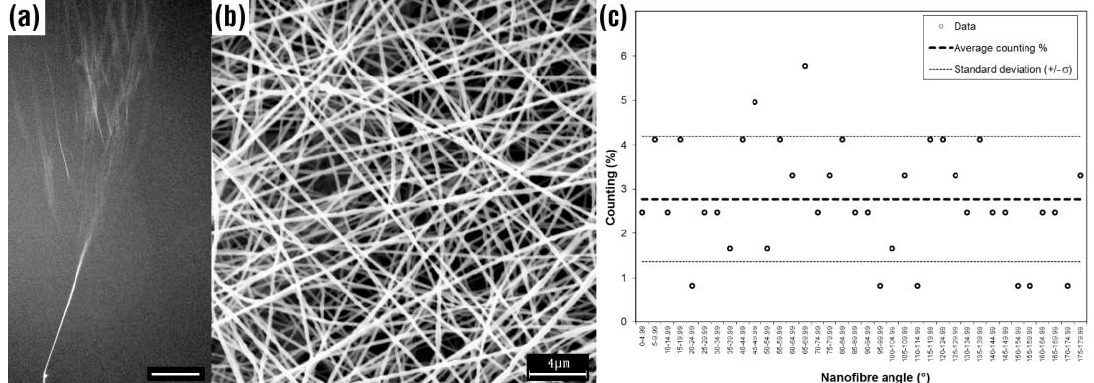
Figure 1. ( a ) Picture of the electrically driven jet produced by electrospinning from a charged metal tip (bottom) toward a collector (up). Scale bar: 2 cm. ( b ) Electron microscopy pictures of randomly oriented electrospun nanofibers collected on a static grounded flat metal collector (scale bar: 4 μ m). ( c ) Plot of the nanofibers orientation (as result of 121 measurements on the nanofiber sample shown in ( b ), vertical 0°). The experiment was carried out using poly(ethylene oxide) (400 kDa) dissolved in water at 7 wt. % concentration and electrospun at 28 kV voltage, 1.8 mL/h flow rate, and 25 cm tip ‐ to ‐ collector distance. (Authors’ own pictures.).